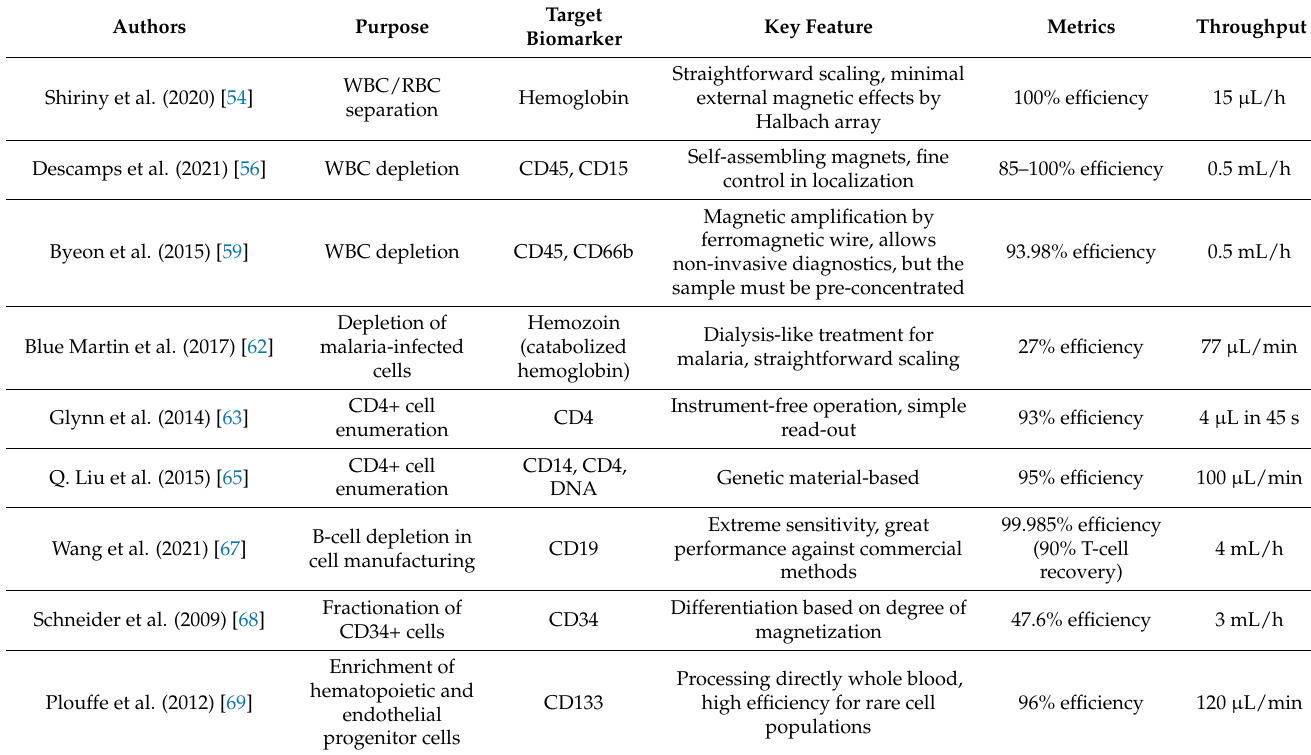
Table 1. Summary of the recent magnetophoretic separation of blood